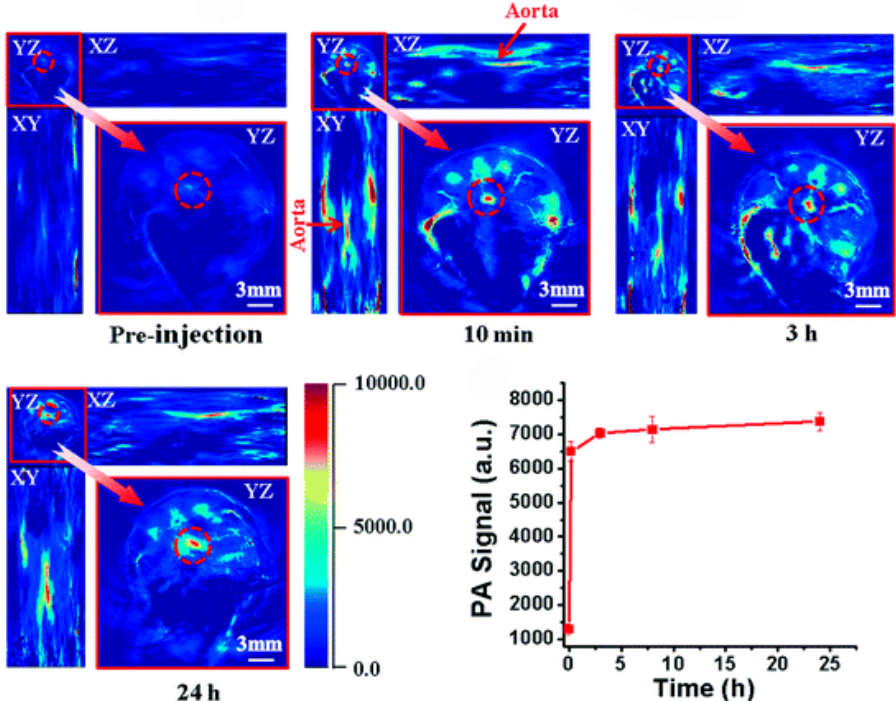
Figure 9. Representative PA imaging of abdominal aorta in an ApoE − / − mouse after intravenous injection of ICG@PEG-Ag2S (longitudinal and transverse view): a low contrast in the whole body of the mouse is evident, while a remarkable enhancement of the PA intensity in the region of the aorta (as indicated by red arrows and red circles) was observed over time. Graph shows quantitative changes over time of PA signals in the aorta of the mouse corresponding to the red circle in images. (Reprinted from Reference [278]. Copyright with permission from © 2016, Royal Society of Chemistry.)